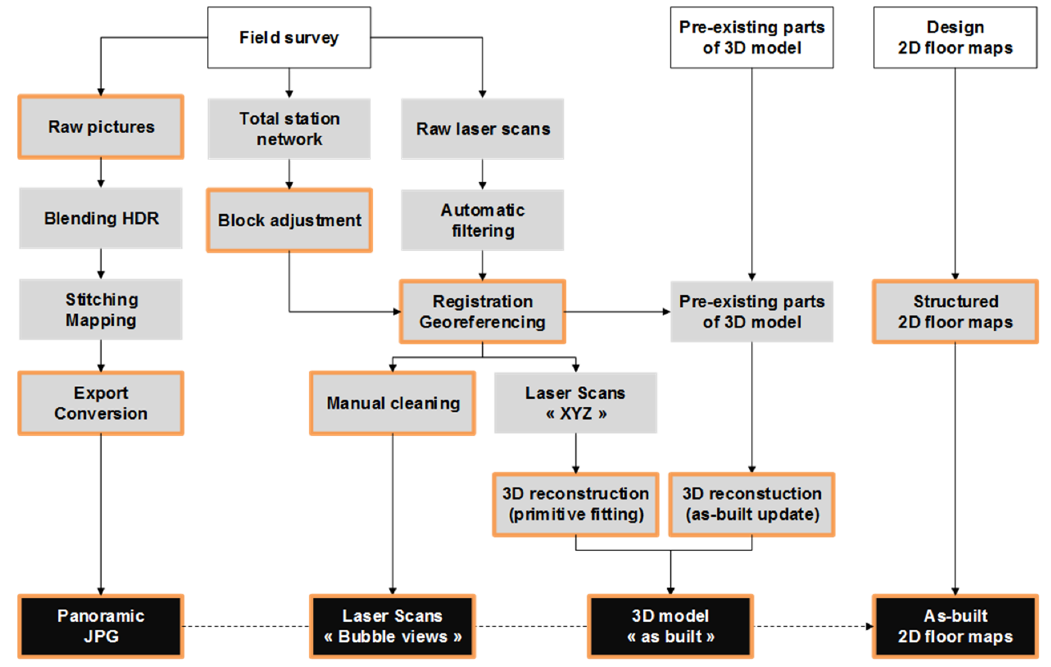
Figure 2. Global framework of as-built data production in the experiment. White boxes are the initial data sources; grey boxes are intermediate data versions; and black boxes are the datasets that composed the virtual replica of a complex building. Orange outlines represent stronger control procedures in the data production process.